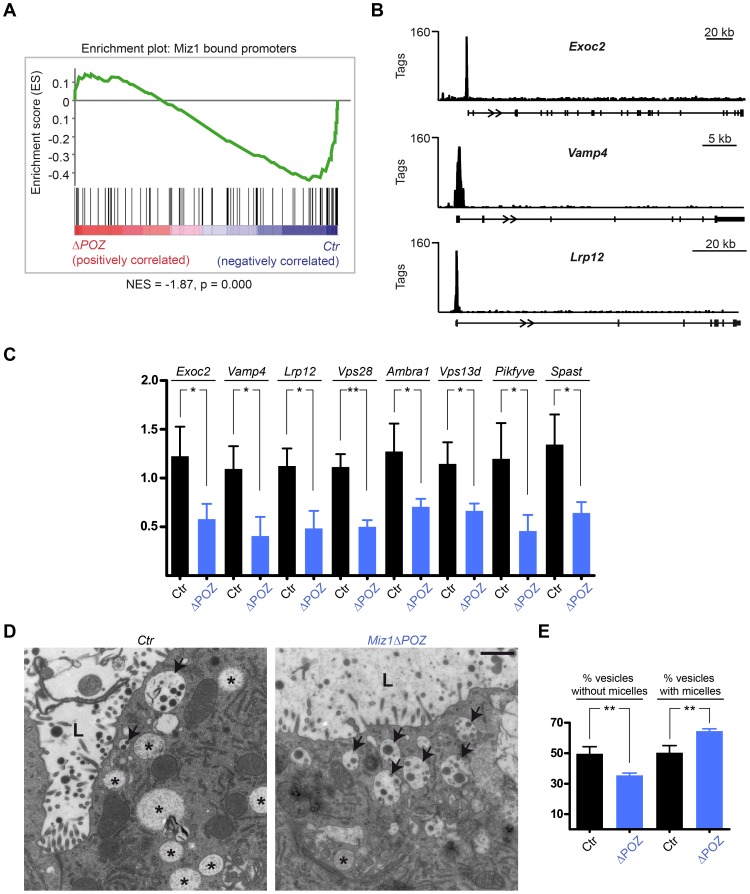
Genes related to vesicular transport processes are bound by Miz1 and down-regulated in Miz1ΔPOZ mammary glands.(A) GSEA analysis comparing the gene expression of wildtype versus Miz1ΔPOZ mammary glands. The 100 Miz1 target promoters with the highest tag number were used as the gene set in this analysis. (B) Browser pictures of Miz1 ChIP-Seq profiles at the Miz1 target genes Exoc2, Vamp4 and Lrp12. (C) Quantitative RT-PCRs testing the expression of genes indicated in Table 1. (D) Electron microscopy showing vesicles with (arrows) and without (asterisks) casein micelles in tissue from control and Miz1ΔPOZ animals. (E) Percentage of the two vacuole types in mammary gland epithelial cells of control and Miz1ΔPOZ animals from lactation day 10. Data obtained from 4 animals per genotype. Total number of vacuoles counted: ctr, 309–379; ΔPOZ, 339–404. Scale bar in D: 1 µm.